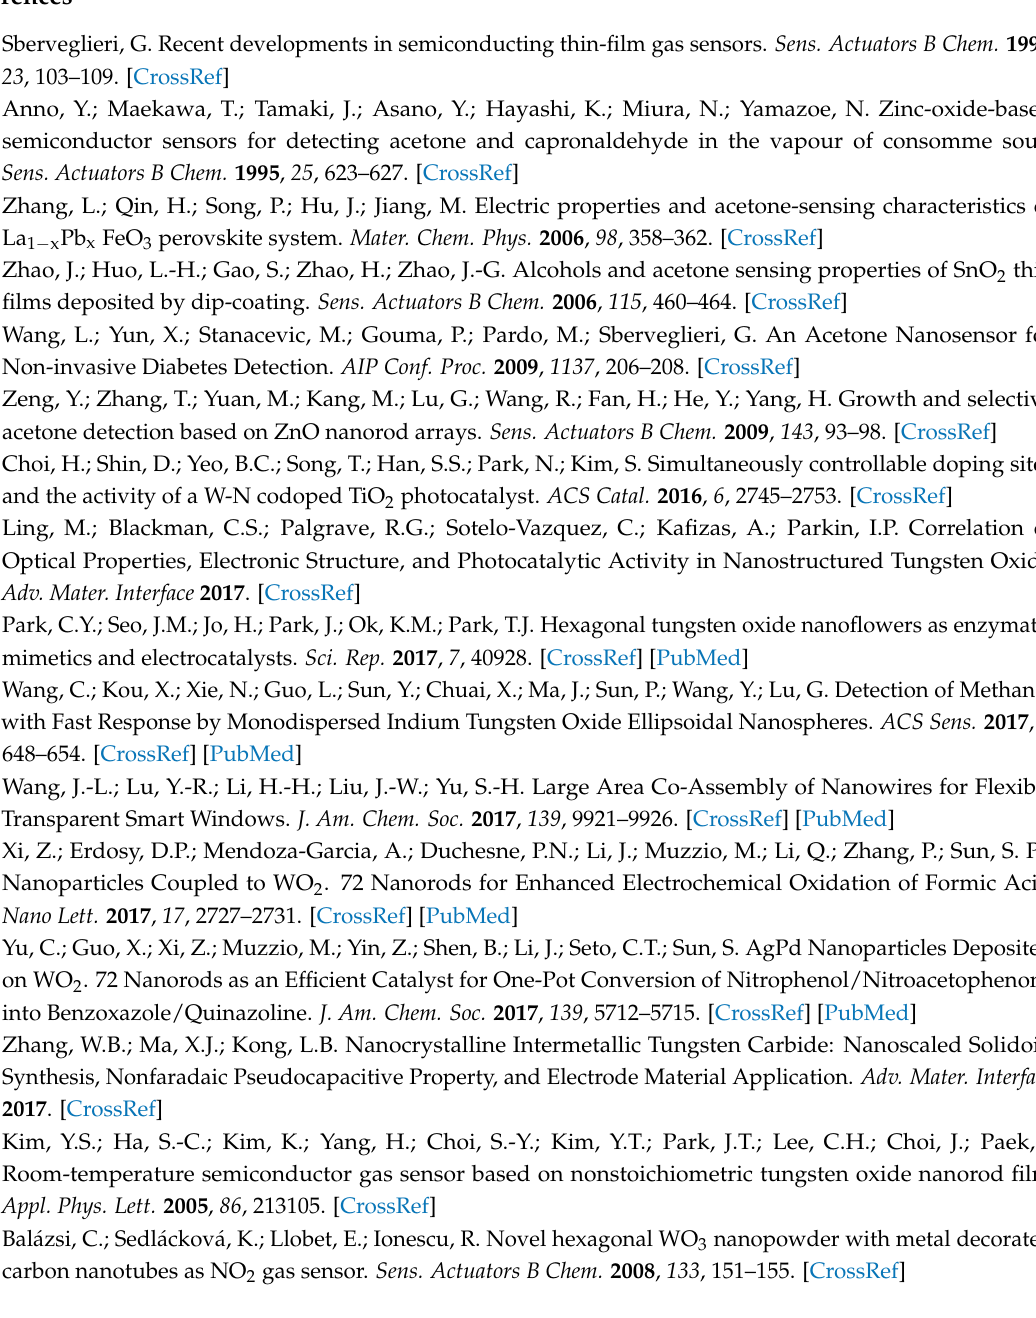
Figure S1: TEM image of GO. Figure S2: TEM image of W 18 O 49 NWs. Figure S3: XRD spectra of GO. Figure S4: XRD spectra of W 18 O 49 NWs. Figure S5: XPS spectra of GO. Figure S6: W 18 O 49 NWs and 0.5wt% W 18 O 49 NWs/rGO composite. Figure S7: Response and recovery time of the sensors. Figure S8: Gas sensing response with different